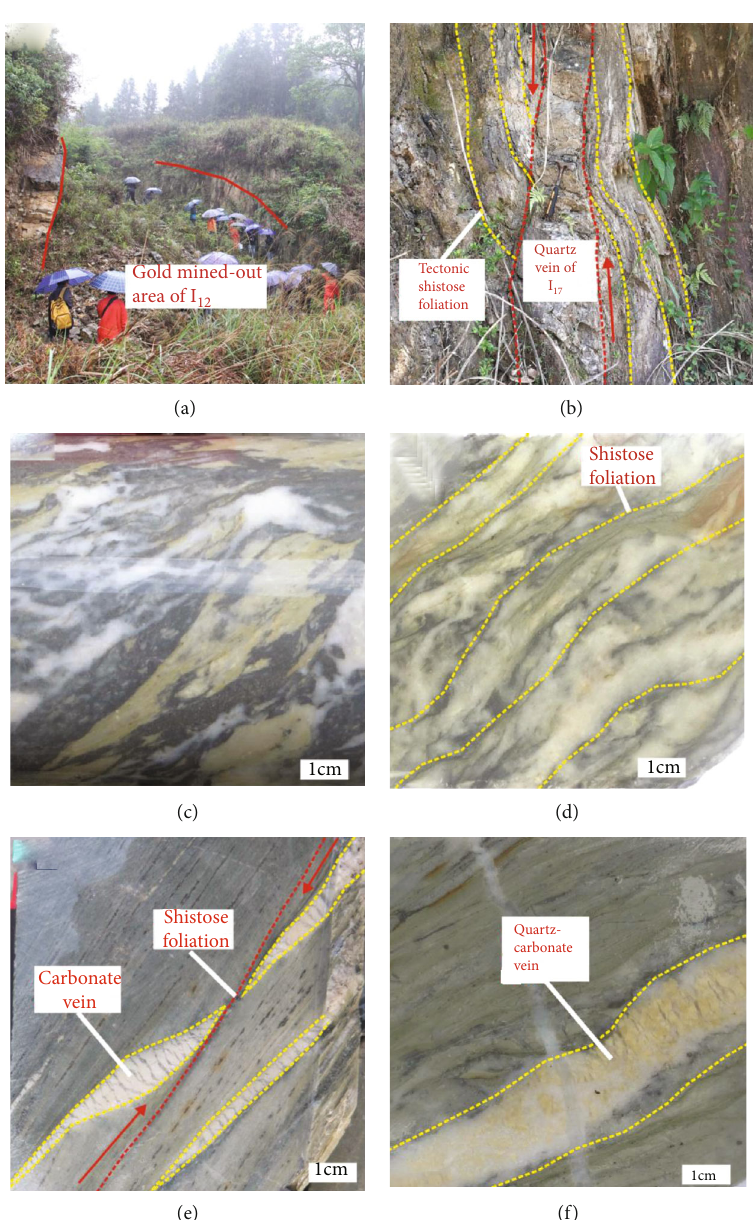
Figure 5: Macroscopic images of auriferous veins and deformation characteristics of the Daping gold deposit. (a) Field image of the NW- trending veins of I . (b) Macroscopic image of the NE-trending veins of I shows distinct features of sinistral shear deformation. (c) 12 17 vein formed in the tectonic shearing environment. (d) The schistose foliation Irregular quartz breccia and sericite slate breccia of I 21 formed by the orientation of the sericite shows ductile deformation in the I . (e) The tensile-shearing space was fi lled by carbonate 21 veins. (f) Quartz-carbonate veins show undulating edge of ductile